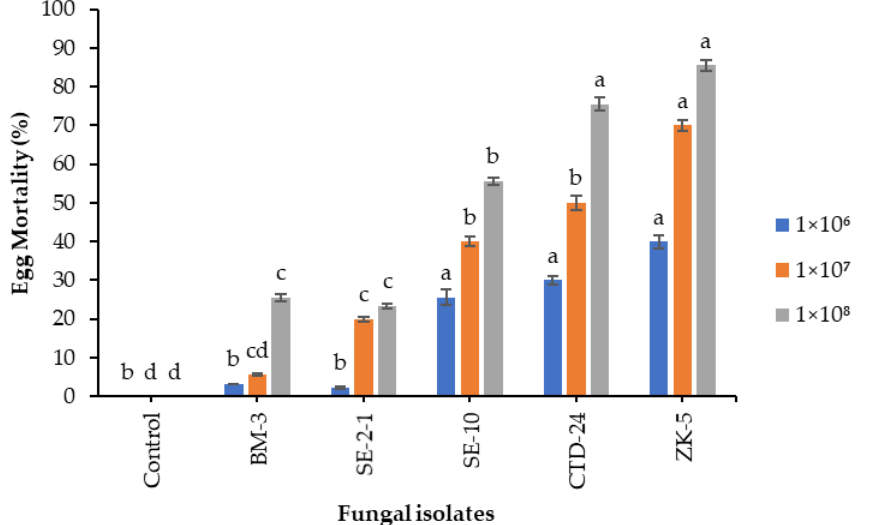
Figure 1. Effects of fungal isolates, i.e., Aspergillus sp. BM-3 and SE-2-1, C. tenuissimum SE-10, P. citrinum CTD-24, and B. bassiana ZK-5 on S. frugiperda egg mortality. Means followed by the same